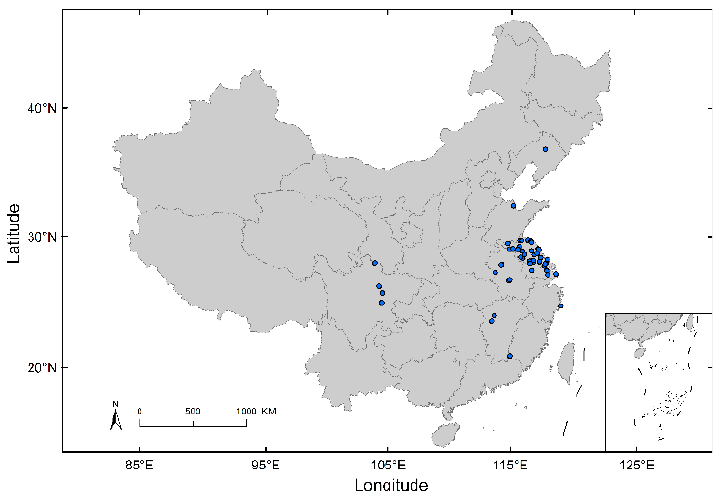
Figure 1. Experimental sites (blue dots) included in the present meta-analysis ( n = 74).